Question: In one sentence, what is this figure communicating?
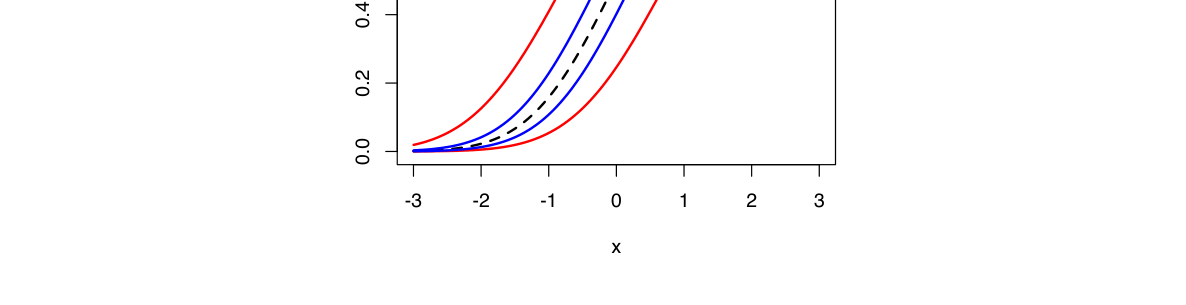
Answer: Lower and upper cdf’s for the random fuzzy numbers studied in Examples 5 and 6, with µ = 0, σ = 1, and a = 0.5 (blue curves) or a = 1.5 (red curves). The Gaussian cdf corresponding to a = 0 is shown as a broken line.